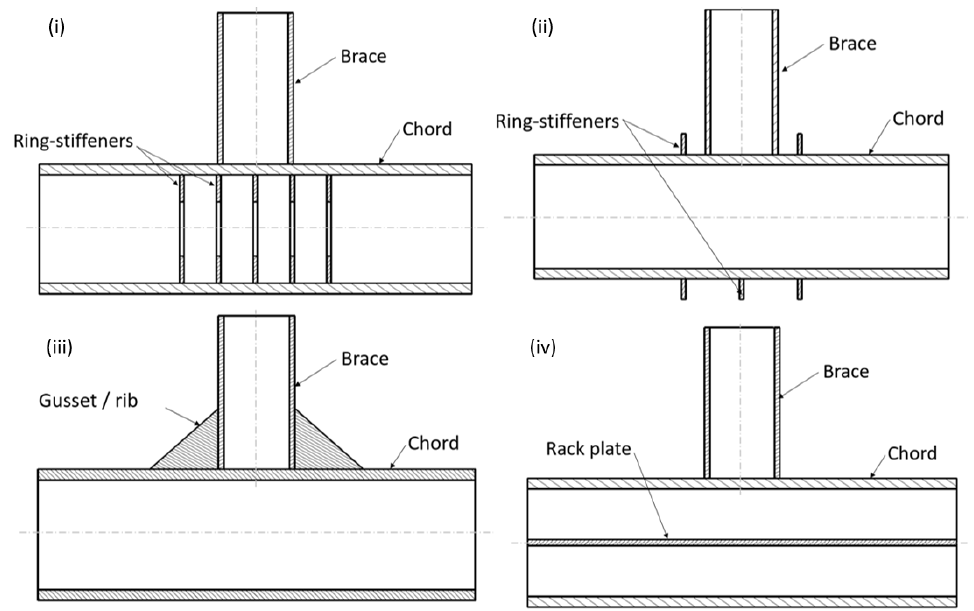
Figure 9. Different arrangements of stiffener welded T-joint. ( i ) Internal ring stiffened, ( ii ) external ring stiffened, ( iii ) rib stiffened, ( iv ) rack plate stiffened